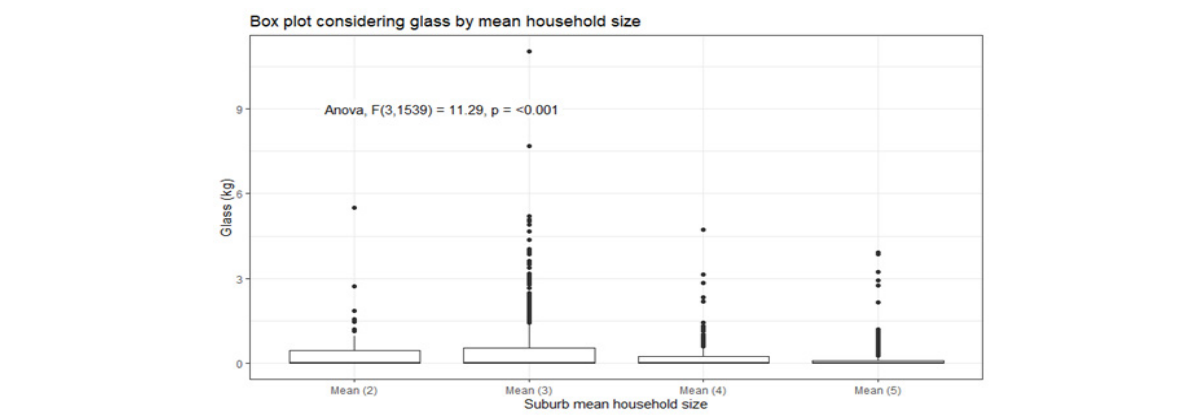
Figure 7: Box plot depicting differences in means of the glass waste fraction between different household sizes in